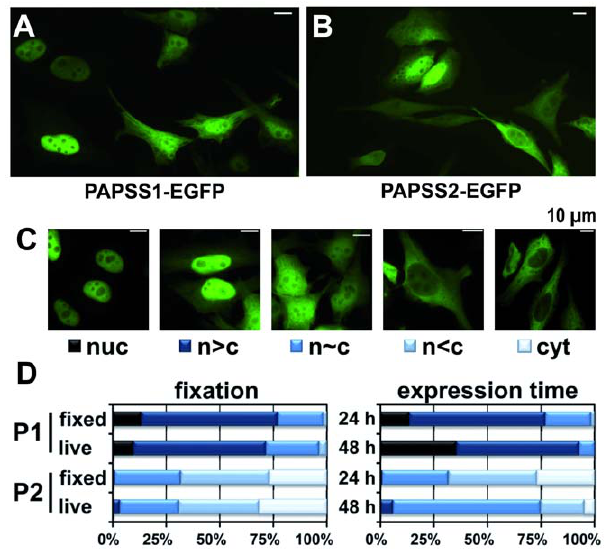
Figure 1. Localisation of PAPS synthase wild-type fusion proteins. A and B , microscopic images of PAPSS1- and PAPSS2-EGFP fusions. Transfected HeLa cells were fixed upon 24 h of fluorescent protein expression. Within every sample, cells with varying protein localisation could be observed. C , schematic for classifying localisation of PAPS synthase fusion proteins and their mutants. D , localisation pattern for PAPS synthase wild-type proteins with respect to the way of fixation and the expression time. A total of 1026 cells for PAPSS1-EGFP (P1) and 1942 cells for PAPSS2B-EGFP (P2) were evaluated, respectively, in fixed HeLa cells after 24 hours of expression. For all other conditions at least 200 cells were scored except PAPSS2-EGFP in living HeLa cells (n=122). EGFP, enhanced green fluorescent